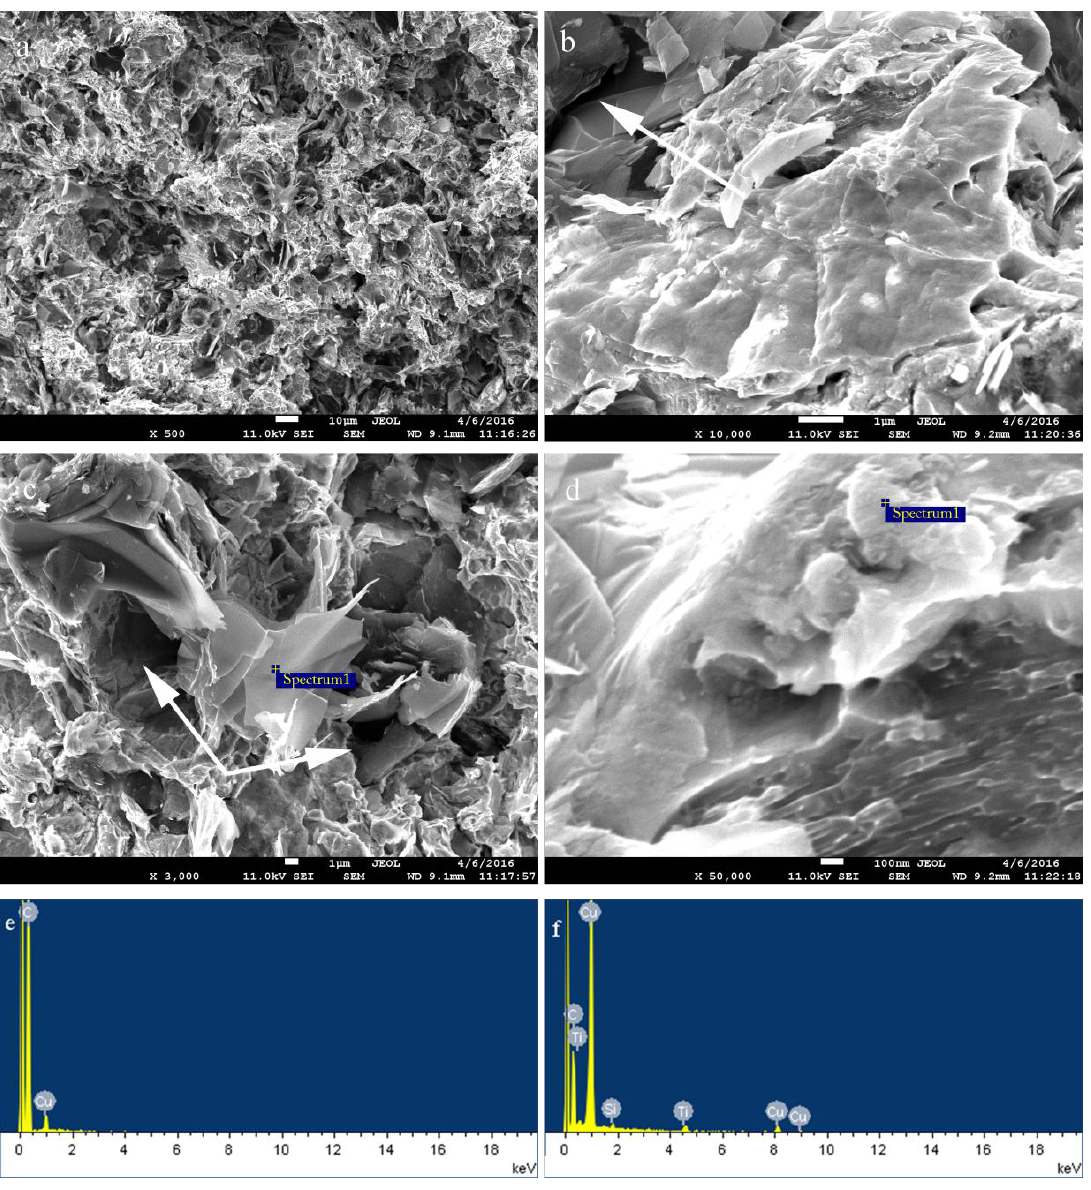
Figure 8. ( a – d ) SEM images of shear fractures of the nanocomposites; the EDS spectra in ( e ) and ( f ) are taken from the marked spots in ( c ) and ( d ), respectively. from the marked spots in ( c , d ),